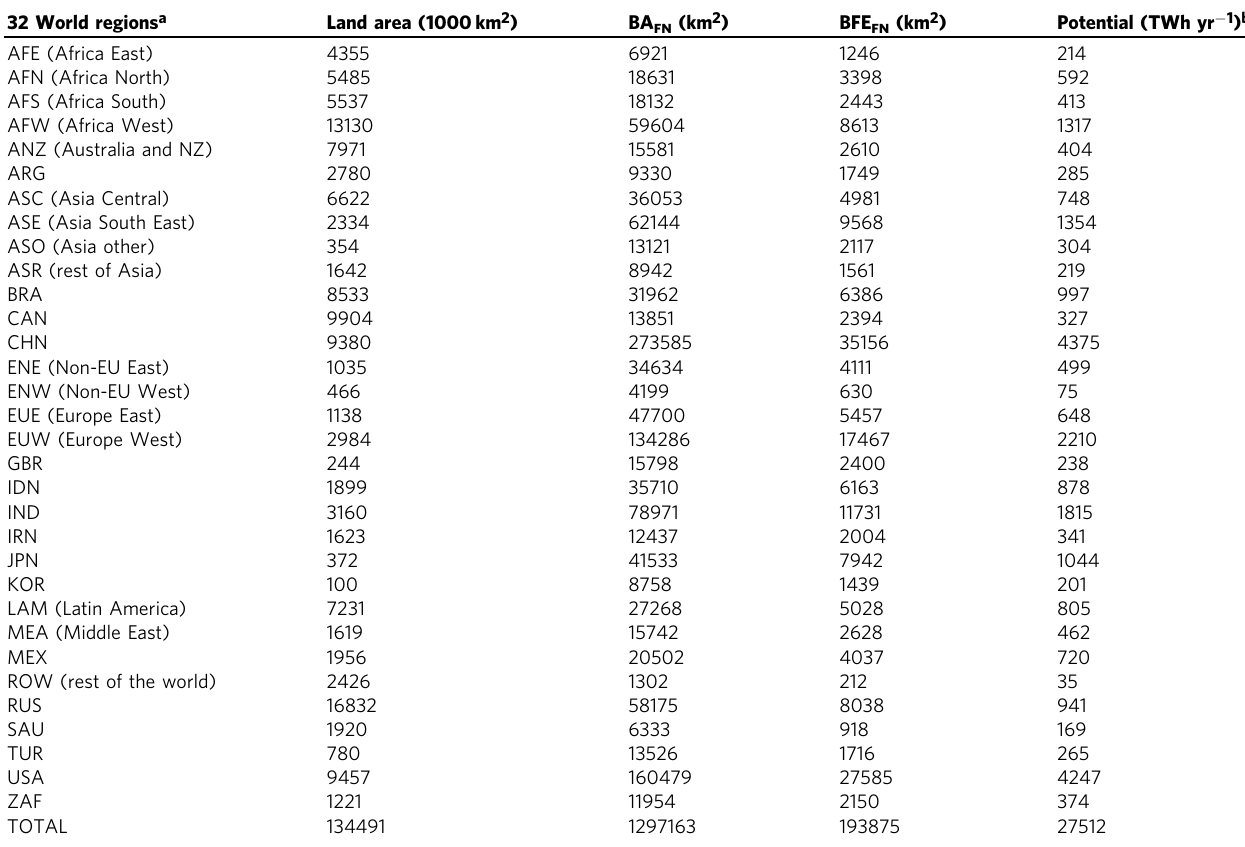
Table 1 32 Regions global distribution of rooftop area and solar potentials.